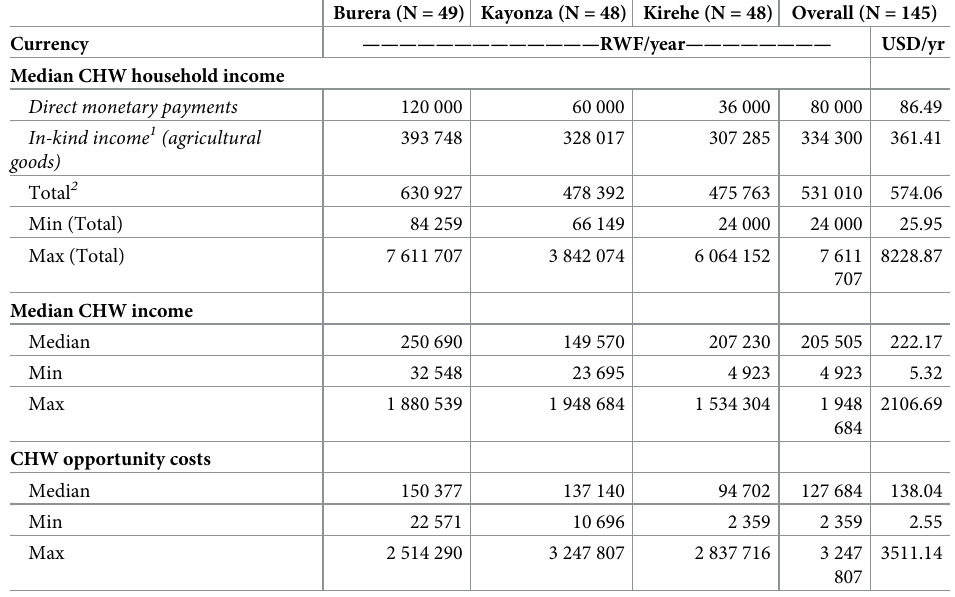
Table 4. Summary of Community Health Worker (CHW) income, monetary outputs and opportunity costs in three districts of Rwanda (2019RWF,